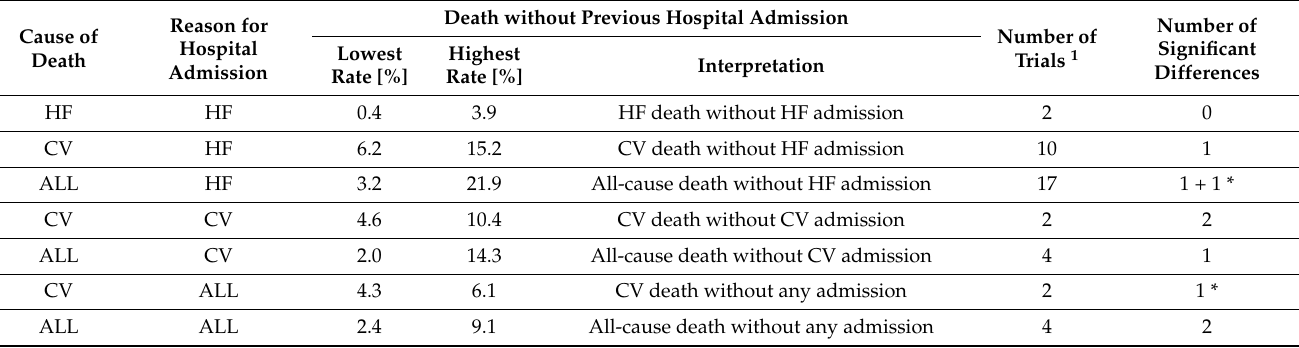
Table 2. Summary of the analyses of death without previous hospital admission.